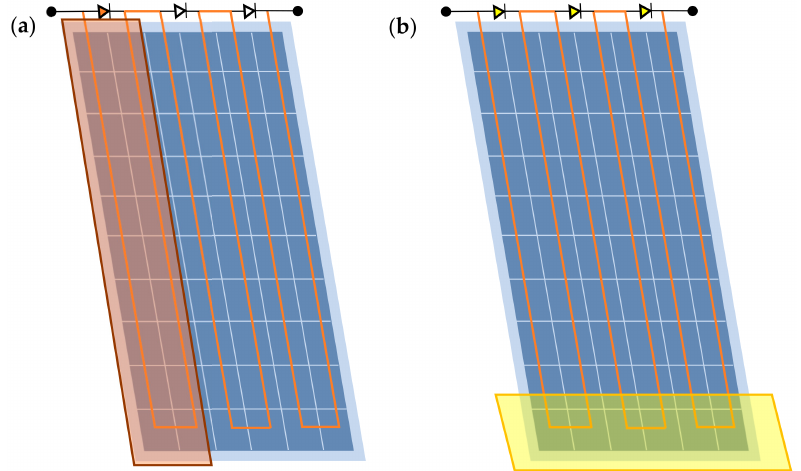
Figure 6. How to simulate panel shading: ( a ) vertical shading, ( b ) horizontal